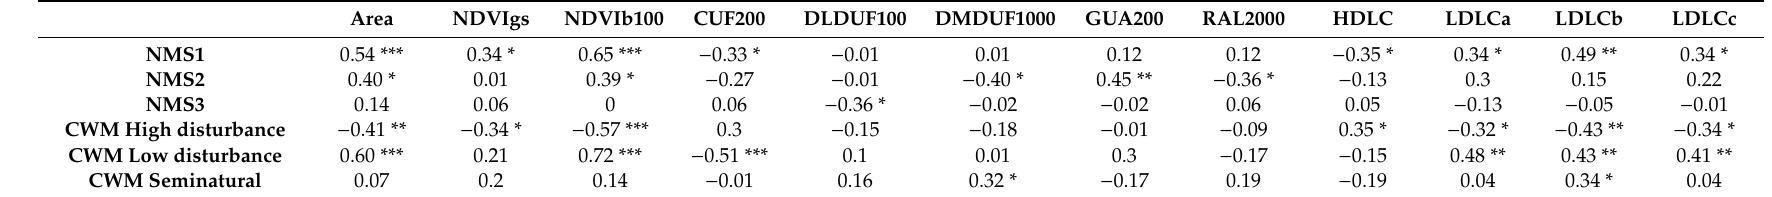
Table 2. Spearman correlation coe ffi cients between lichen community ordination axes (NMS1, NMS2, and NMS3), lichens CWM (high disturbance, low disturbance, and seminatural) and the environmental variables. Significance level is indicated by the asterisk: * = p < 0.05; ** = p < 0.01; *** = p < 0.001. Environmental variables: Area is the area of each green space; NDVIgs is the NDVI value for the green space centroid; NDVIb100 is the NDVI value for a 100 m bu ff er around each green